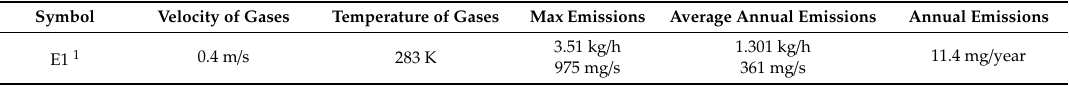
Table 2. Methane (CH 4 ) emissions to the atmosphere during the modelling period.